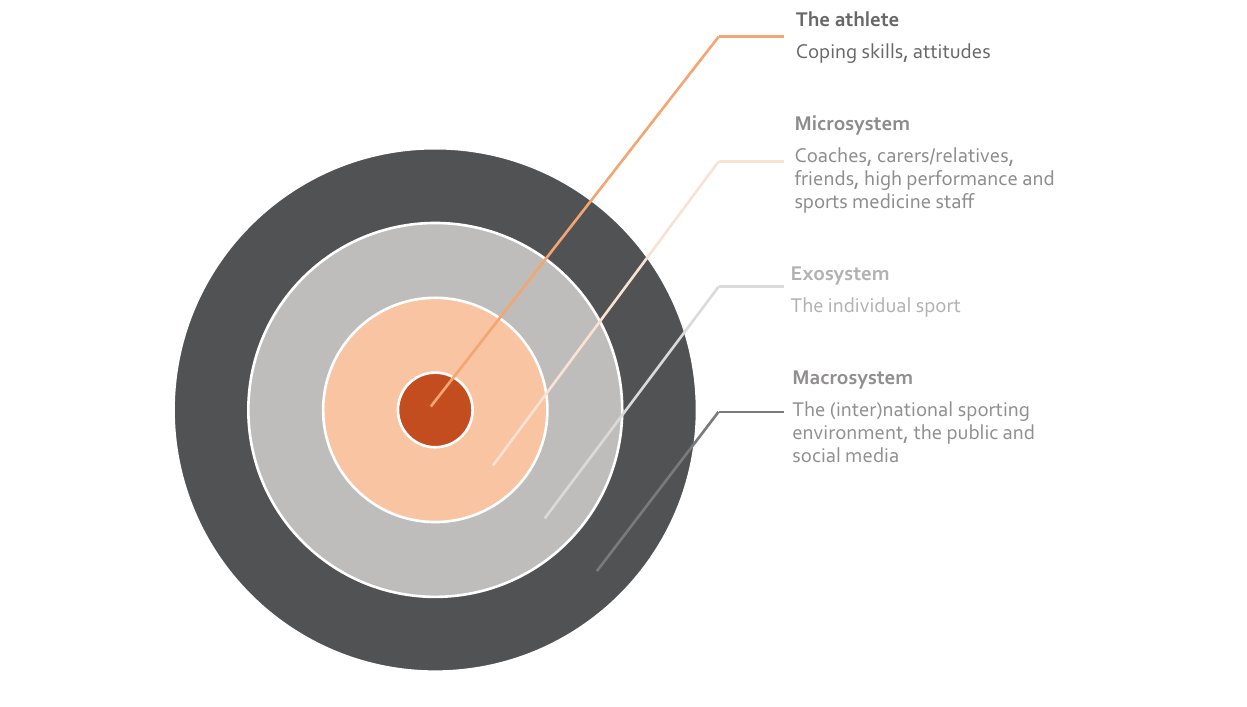
Frontiers in Psychology |